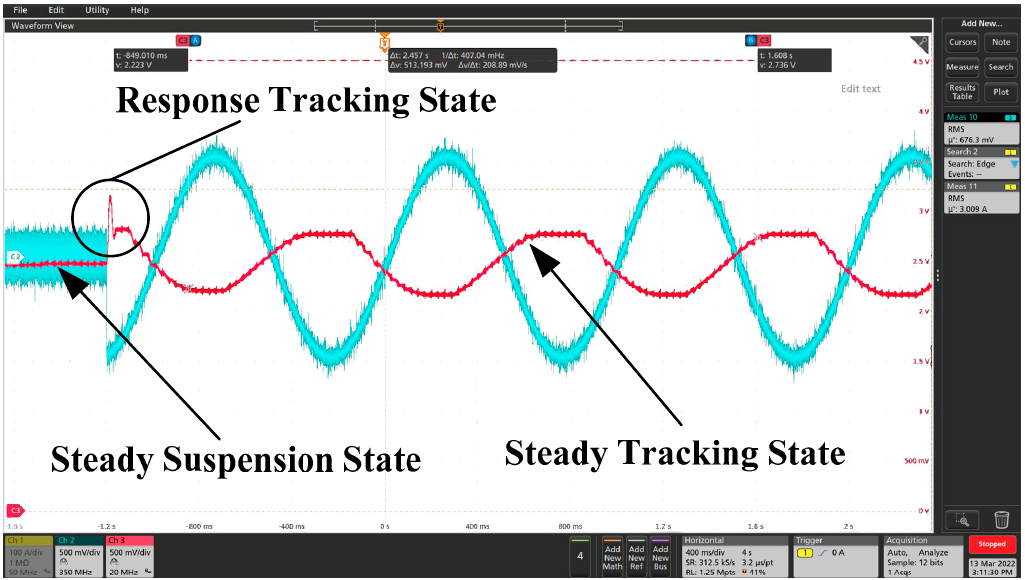
Figure 9. Displacement–time response characteristics curve under sinusoidal excitation signal.